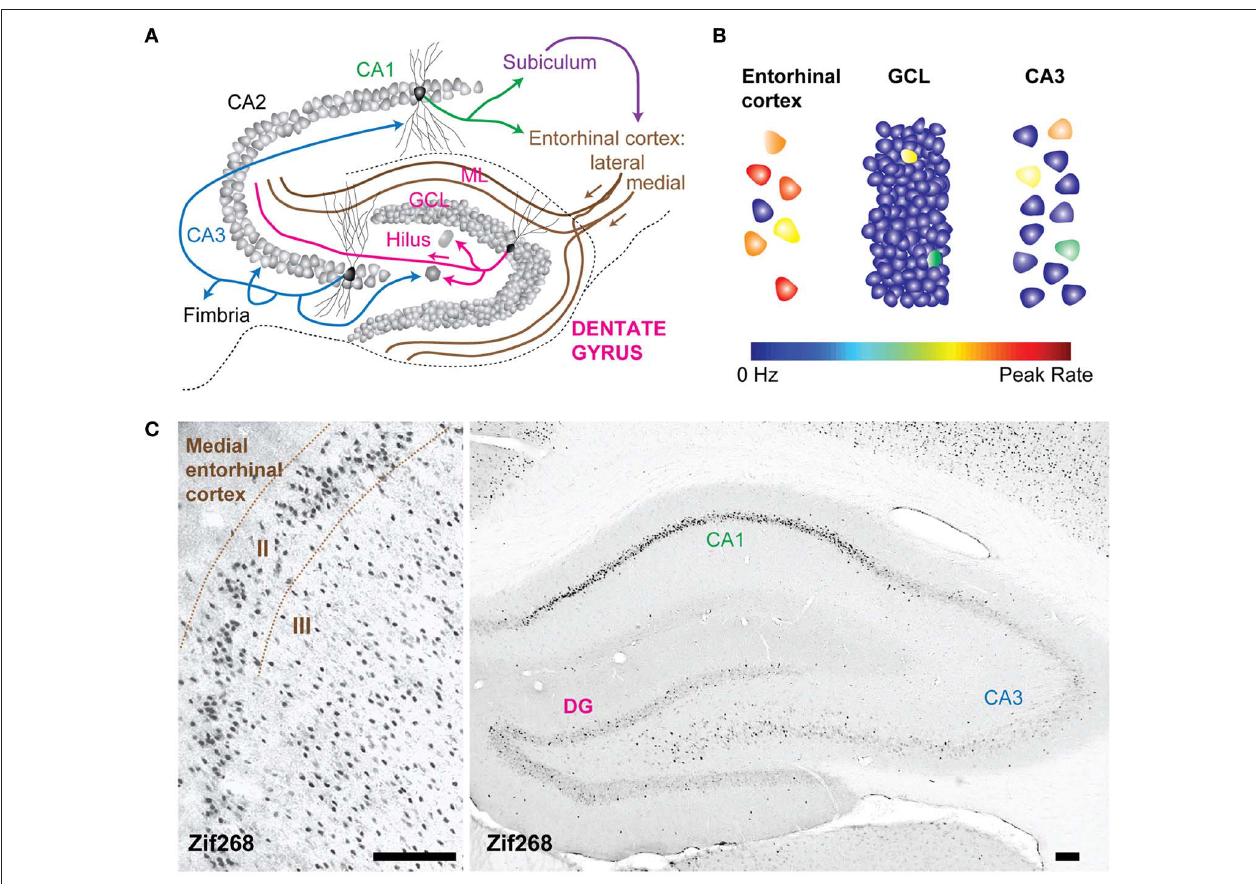
granule cell layer is low, because of a low proportion of neurons that fire action potentials and because the average firing rates of active neurons are low. (C) Expression of zif268, (activity dependent immediate early gene) in the rat entorhinal cortex (left) and hippocampus (right) after spatial exploration in an open field. Fewer neurons in the DG are positively labeled by zif268 immunoreactivity relative to the entorhinal cortex suggesting that a smaller proportion of the total population was active during spatial exploration. GCL, granule cell layer; ML, molecular layer. All calibration bars are 100 μ